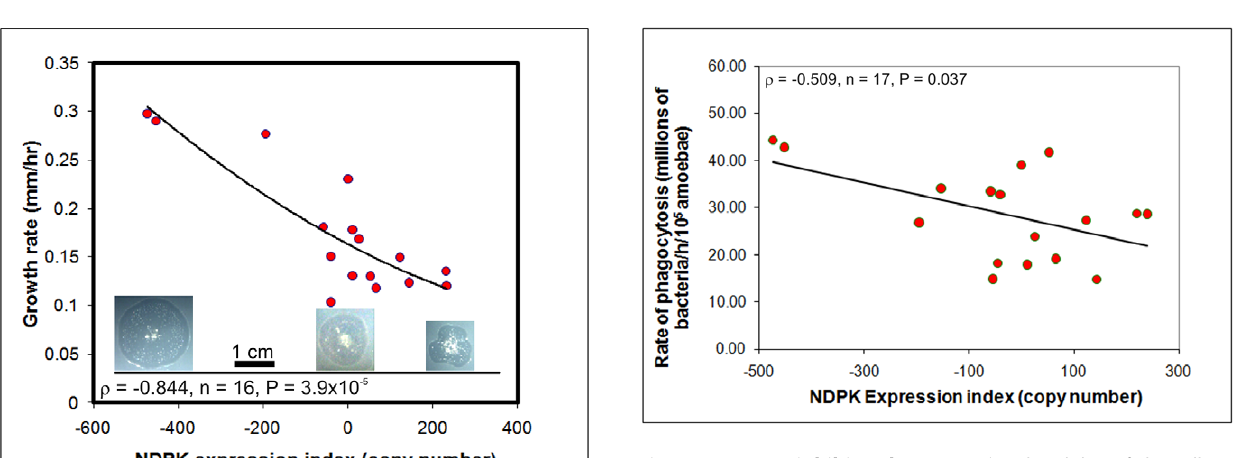
Figure 6. NDPK inhibits phagocytosis. The ability of the cells to ingest a fluorescent bacterium (DsRed-expressing E.coli ) was assayed and showed that the phagocytic uptake of bacteria was negatively correlated with the NDPK expression index (defined as in Fig. 5). The correlation was significant at P , 0.05 (Pearson product-moment correlation coefficient r ). Each point is the mean for a single transformant from duplicate measurements made in each of five